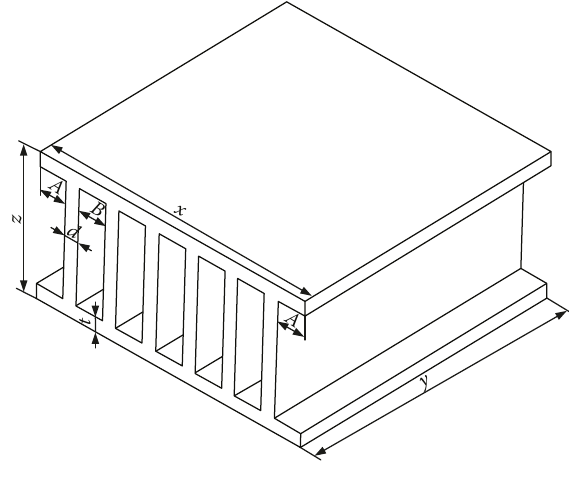
Figure 2: A new type solar